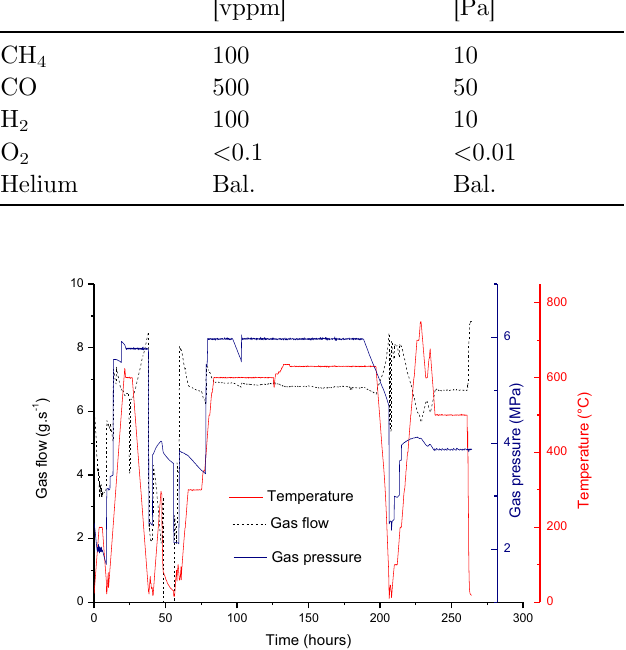
Fig. 2. Parameters during the fi rst period of the test operation of High Temperature Helium Loop.